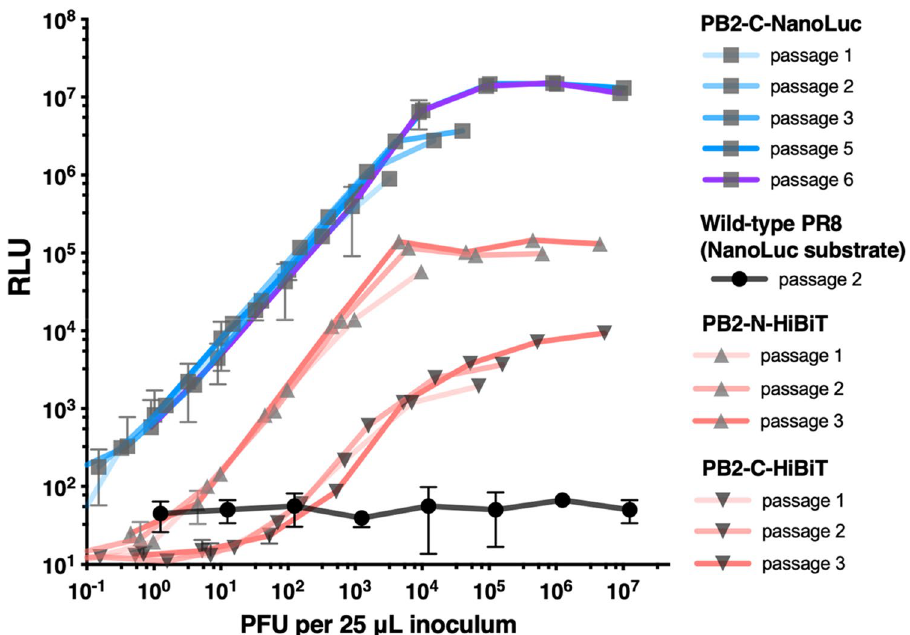
Figure 3. Functional stability of luciferase activity in bioluminescent IAVs after sequential passage. PB2-C- NanoLuc (blue) and PB2-N-HiBiT and PB2-C-HiBiT (pink) IAVs were sequentially passaged in MDCK cells at 37 °C. Each passaged IAV was serially diluted, and IAV luciferase activity was determined in MDCK cells at 12 h after inoculation. Stability of NanoLuc or HiBiT tag in PB2-C-NanoLuc, PB2-N-HiBiT, and PB2-C-HiBit was confirmed after 3–6 sequential passages of these IAVs in MDCK cells. RLU with NanoLuc substrate from MDCK cells infected with wild-type PR8 IAV (black) was plotted as a reference. Data reported as mean ± SD (N = 3). PFU plaque forming units, RLU relative luciferase